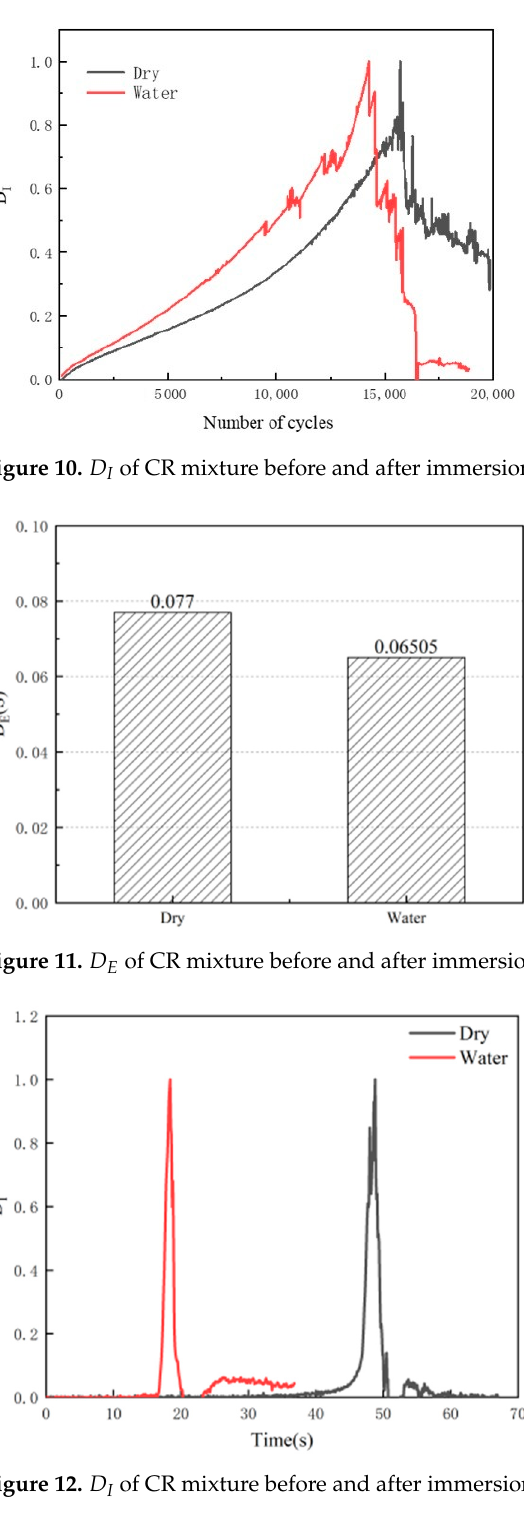
Figure 9. D E of CR mixture before and after immersion under medium temperature fatigue failure.